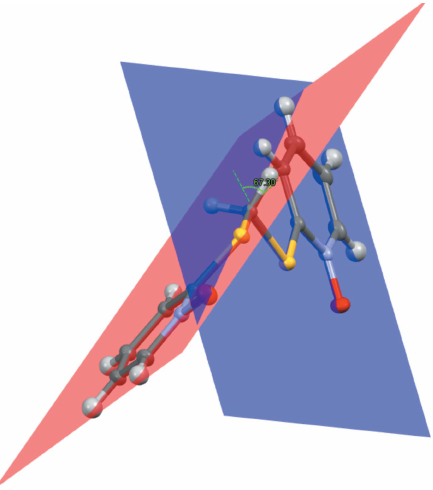
Figure 2 Depiction of the dihedral plane angle of the two pyridine N-oxide moieties visualized within Mercury (Macrae et al. , 2020).